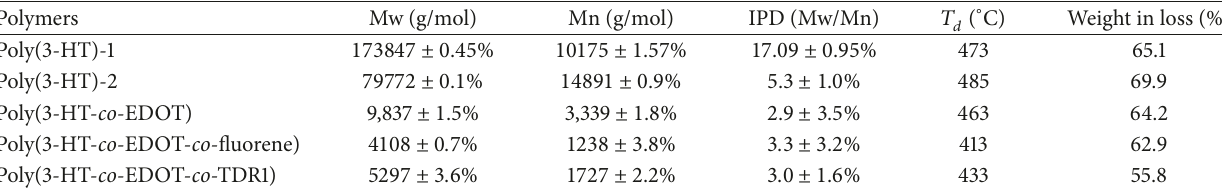
Table 3: Molecular weight distributions and thermal properties of the polymers.